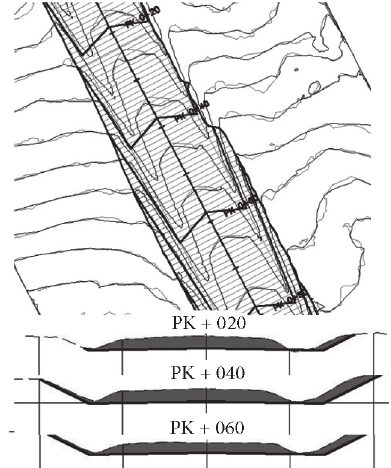
Table 1. Height differences between the surface